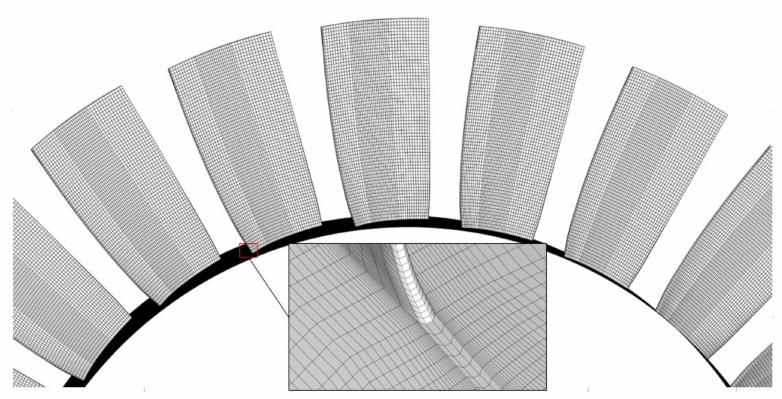
Figure 2. Computational grid around main blade edge.